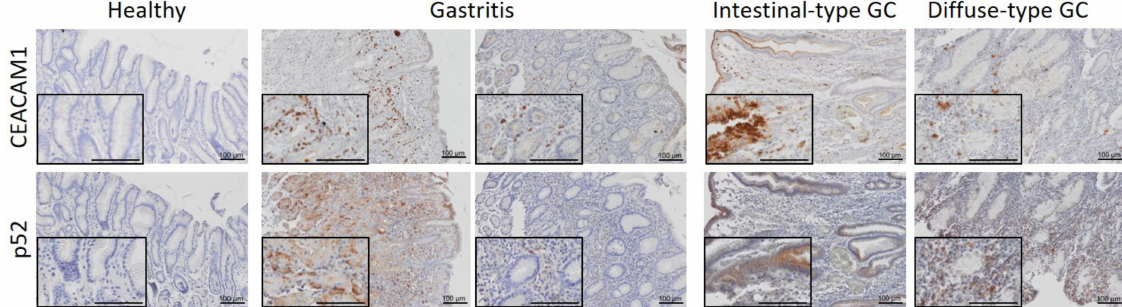
Figure 4. Concomitant CEACAM1 and p52 expression in human gastritis and tumor samples. Representative images of normal mucosa ( n = 3), gastritis ( n = 13), intestinal-type gastric cancer (GC) ( n = 8), and diffuse-type GC ( n = 3) tissue are shown, which were stained for CEACAM1 and p52 (NF- κ B2). Scale bar: 100 µ